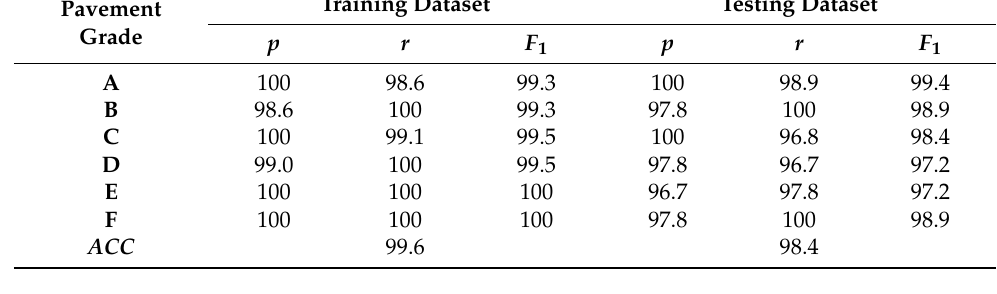
Table 3. Evaluation results of the training and test sets (unit: %).